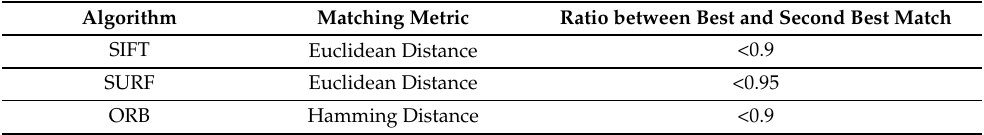
Table 4. Matching parameters for SIFT, SURF, and ORB algorithms.